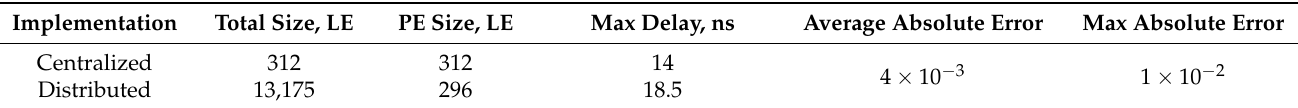
Table 2. Experimental results.